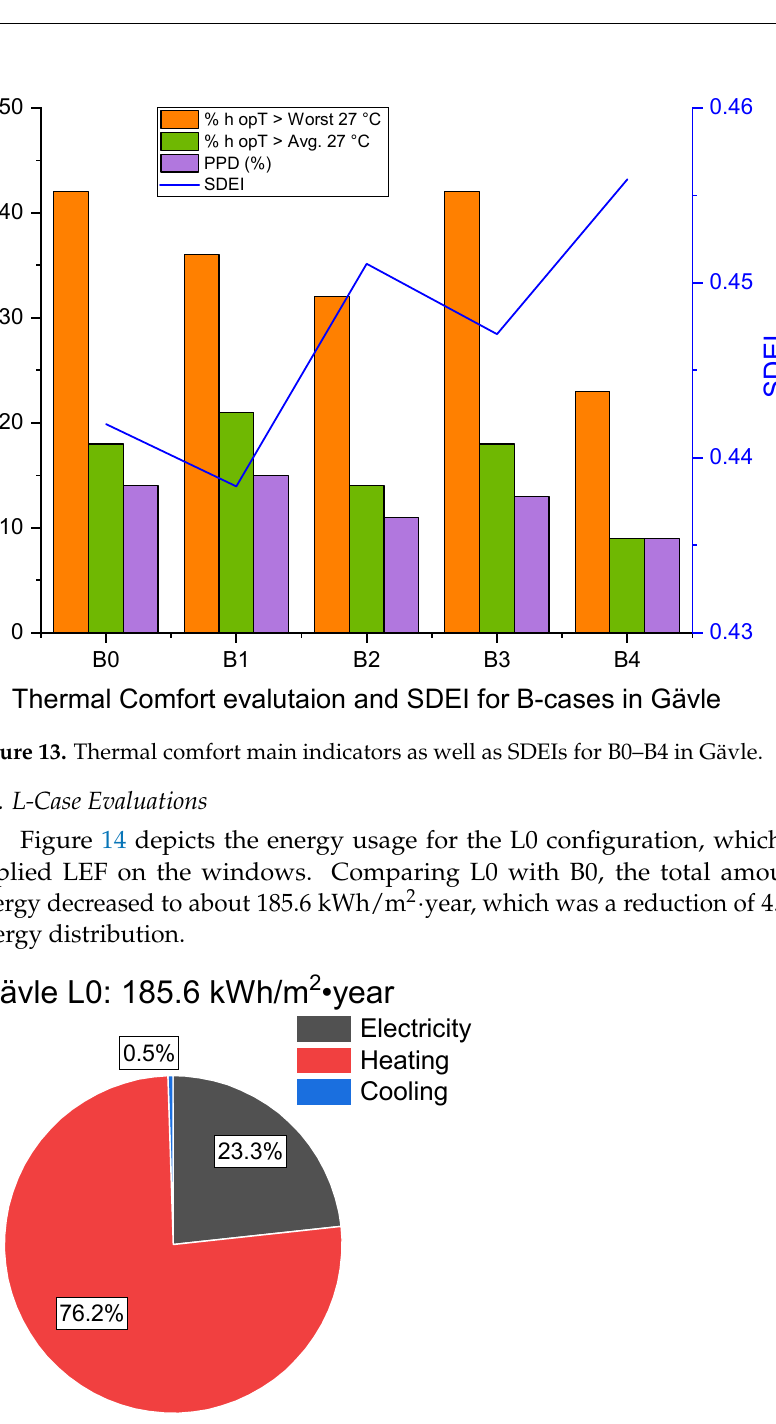
Figure 12. SHG for B0 in different locations.